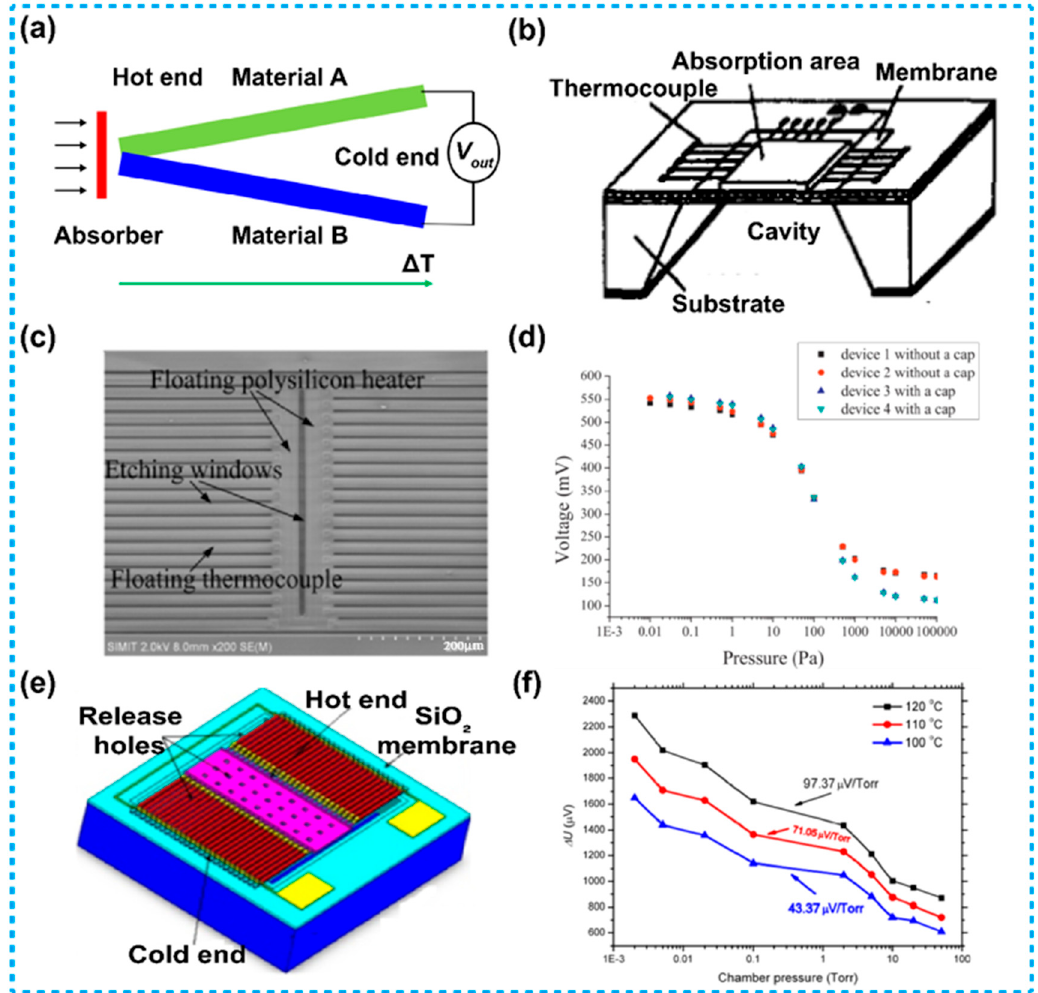
Figure 5. Thermocouple-based Pirani sensors. ( a ) A schematic diagram illustrating working principle of the Seebeck effect. ( b ) A schematic diagram of a conventional thermopile device. ( c ) Diagram of a thermocouple-based Pirani sensor with a heater located beside the hot ends [89]. ( d ) The output voltage versus gas pressure of the Pirani sensor mentioned in ( c ), the sensitive range of the device was 5 × 10 − 3 to 10 5 Pa. ( e ) Diagram of a thermopile used for constructing a thermocouple-based Pirani sensor [90]. ( f ) The output voltage versus gas pressure at different heating power of the Pirani sensor mentioned in ( e ), the sensitive range of the device was 10 − 1 to 10 4